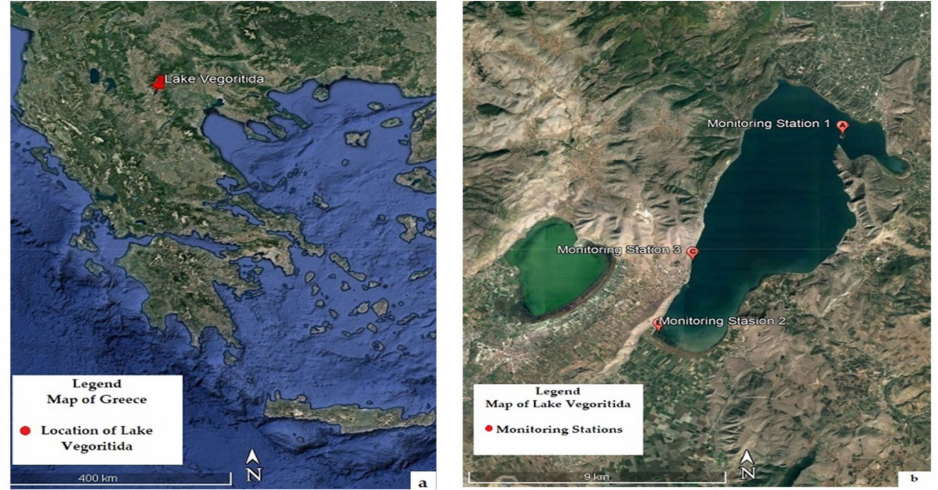
Figure 1. ( a ) Map of Greece presenting the location of Lake Vegoritida; ( b ) Map of study area showing the location of monitoring stations (modified from Google Earth